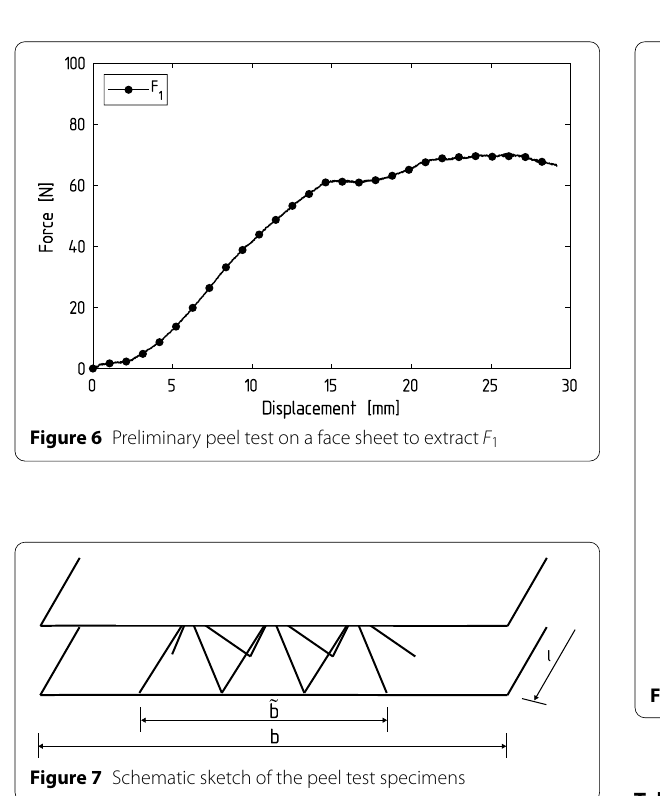
Table 3 Geometric paramters of specimens for climbing